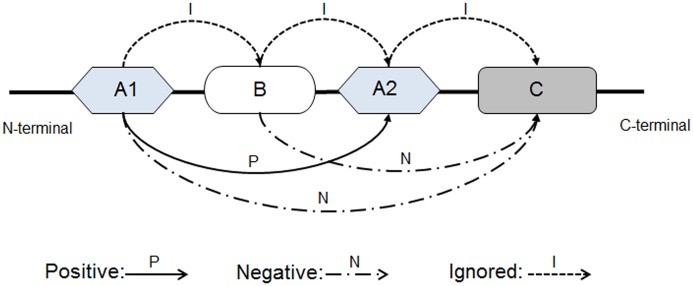
An illustration of the procedure to generate the samples.A 3-domain chain is defined as (A1A2)(B)(C). A1 and A2 form one structure domain, while B and C are independent domain, respectively. The (A1A1) is treated as “Positive” sample; (A1C) and (BC) as “Negative” and other combinations are ignored.